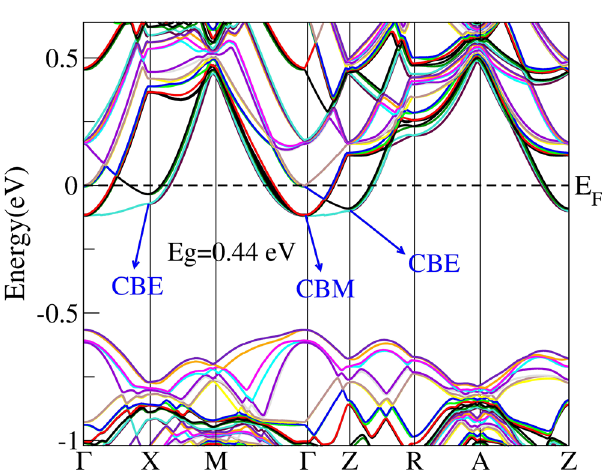
Figure 4. Calculated band structures of ZrNiSn ( a ), Hf 0.25 Zr 0.75 NiSn ( b ), and Hf 0.5 Zr 0.5 NiSn ( c ).